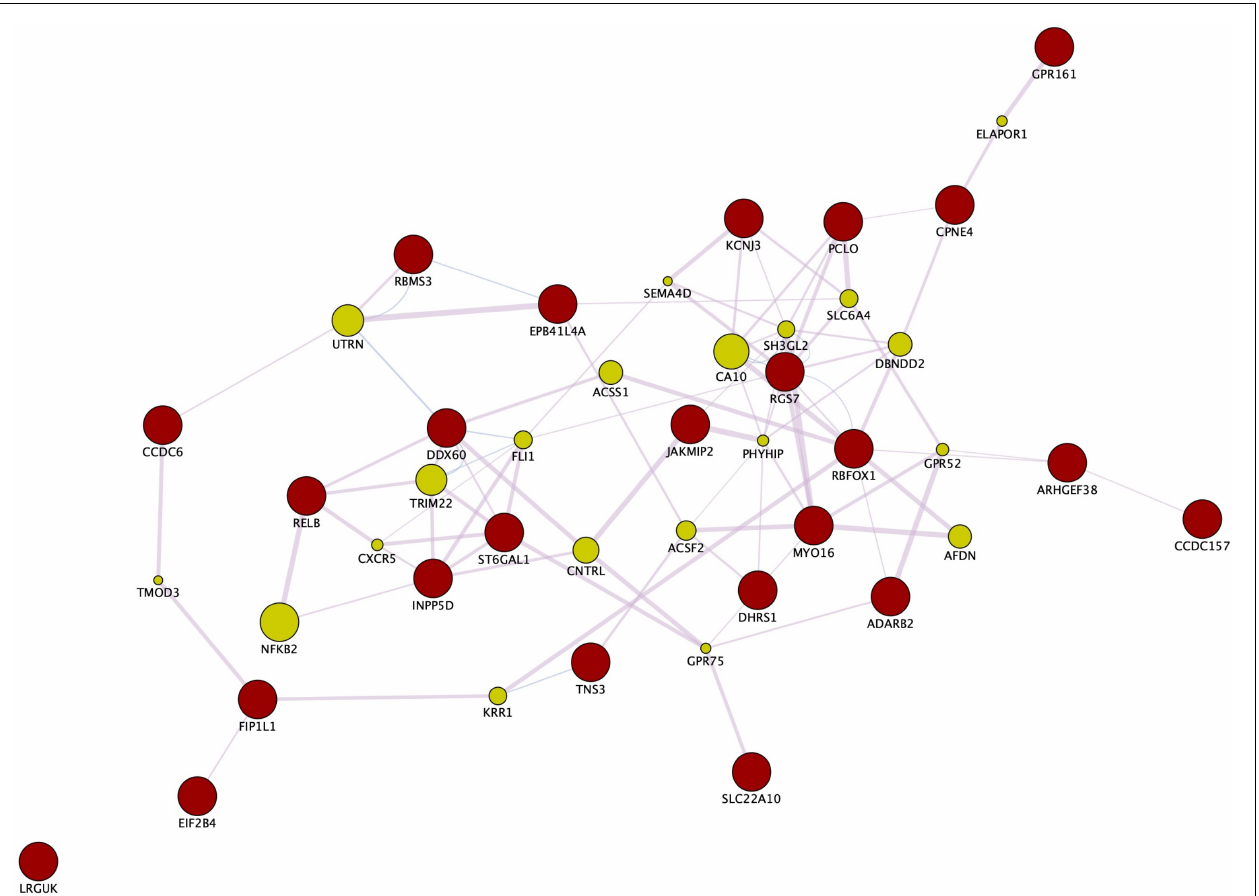
FIGURE 9 | Gene co-expression network. Enrichment analysis through GeneMANIA and Cytoscape of the genes mapped by the SNPs that compose the fasting insulin rPRS show that these genes are part of a co-expression network in Homo sapiens . Red circles indicate query genes, whereas green circles indicate related genes added by GeneMANIA. GeneMANIA translates mRNA expression data from Gene Expression Omnibus (GEO) to functional association networks that connect co-expressed genes through the pink lines displayed. The node sizes represent gene scores, indicating the number of paths that start at a given gene node and end up in one of the query